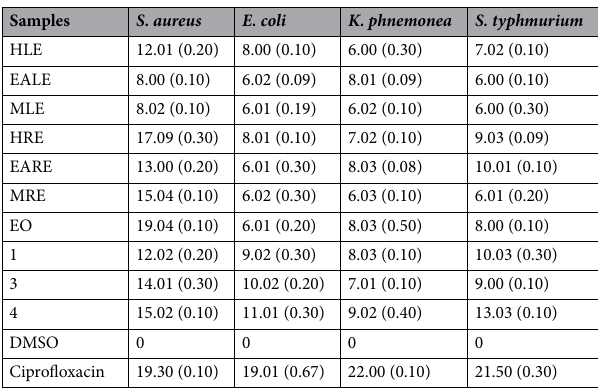
Table 3. Inhibition zone (in mm) displayed by constituents of the leaves and roots of O. cufodontii at dose of 50 µg/mL. Samples were analyzed in triplicates and expressed as m ± SD. HLE hexane leaves extract, EALE EtOAc leaves extract, MLE MeOH leaves extract, HRE hexane root extract, ERE EtOAc root extract, MRE MeOH root extract, EO Essential oil.